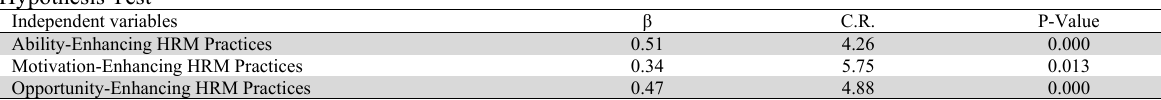
Hypothesis Test Independent